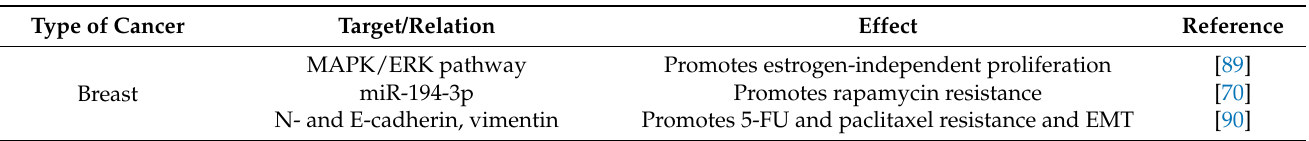
Table 1. Functional and regulatory mechanisms of linc-ROR in